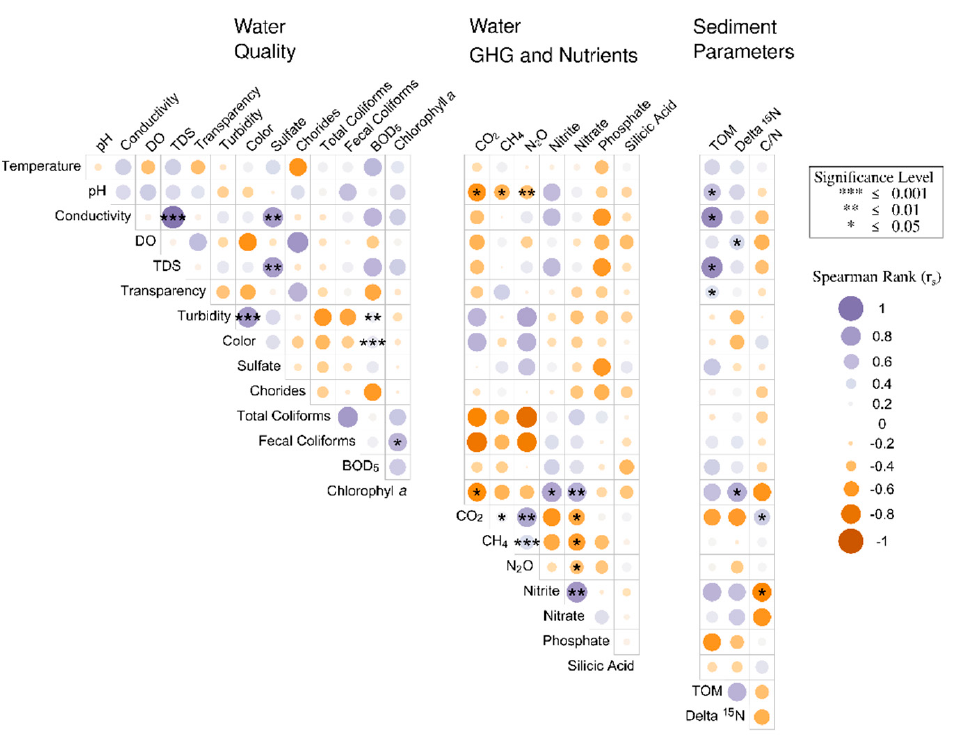
Figure 6. Spearman correlation analysis between water quality parameters, GHG, nutrients and sediment